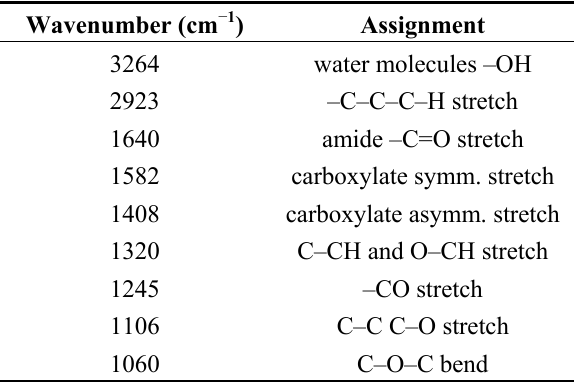
Table 3. Peak wavenumbers (cm − 1 ) and assignments for CMC